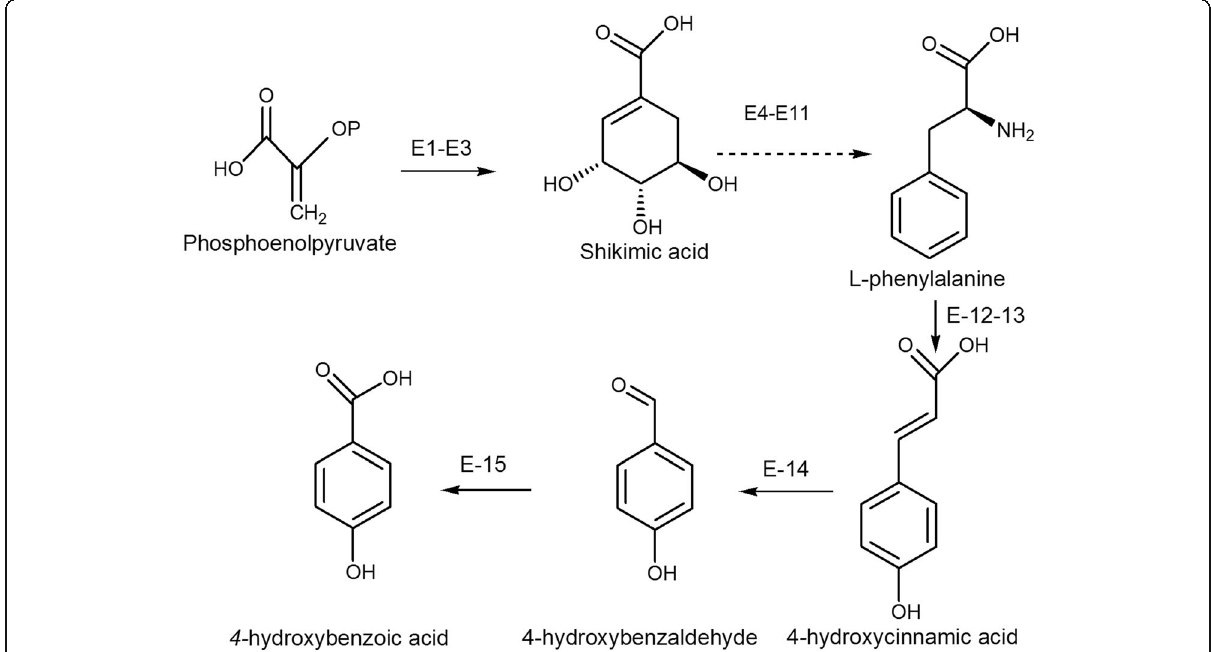
Fig. 3 Schematic representation of the possible biosynthetic pathways for 4-hydroxybenzaldehyde ( 1 ), 4-hydroxybenzoic acid ( 2 ), 4- hydroxycinnamic acid ( 3 ) in Thysanolaena maxima Roxb. E1-3-deoxy-7-phosphoheptulonate synthase, E2-3-dehydroquinate synthase, E3-shikimate dehydrogenase, E4-shikimate kinase, E5-3-phosphoshikimate 1-carboxyvinyltransferase, E6-chorismate synthase, E7-chorismate mutase, E8- arogenate dehydratase, E9-bifunctional aspartate aminotransferase, E10-histidinol-phosphate aminotransferase, E11-tyrosine aminotransferase, E12- phenylalanine ammonia-lyase, E13- cinnamate-4-hydroxylase, E14-4-hydroxybenzaldehyde synthase, E15-4-hydroxybenzaldehyde